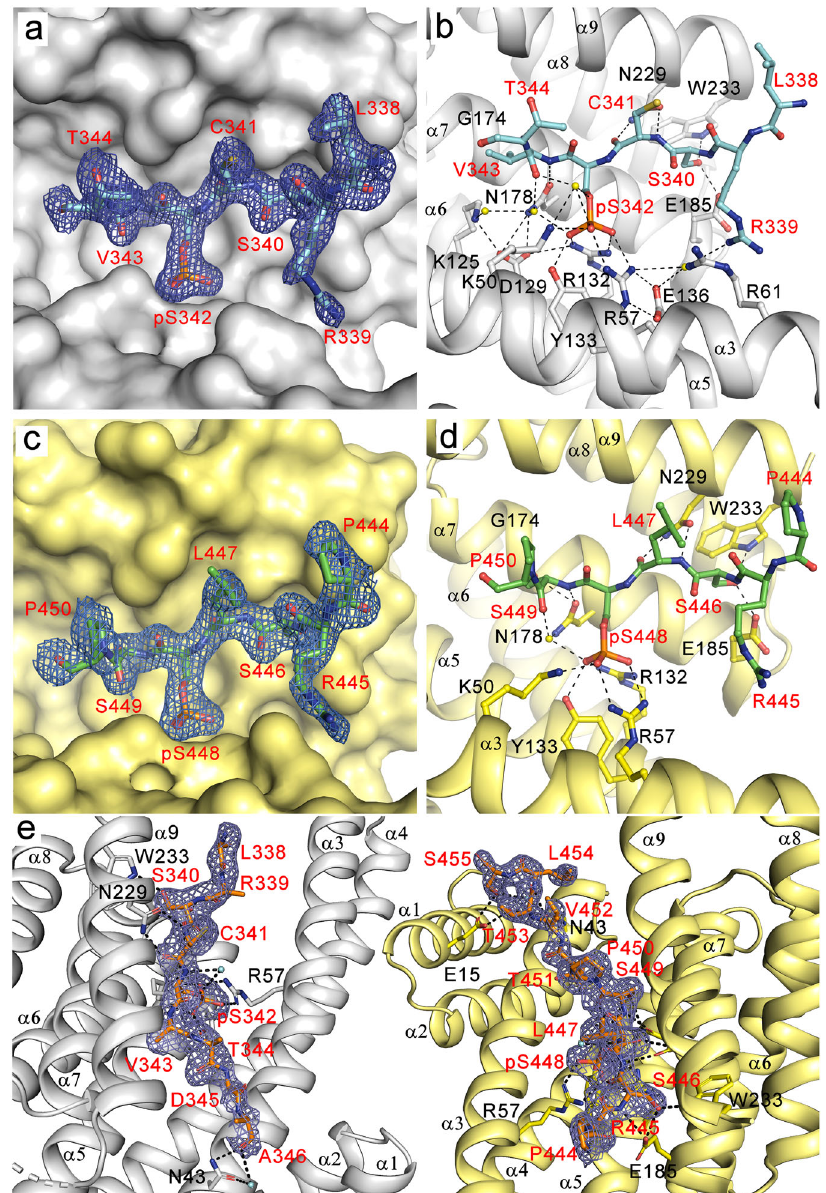
Fig. 5 Crystal structures of Nedd4-2 peptides containing the 14-3-3 binding motifs pSer342 and pSer448 bound to 14-3-3 γ and 14-3-3 η . a Detailed view of the crystal structure of the 14-3-3 γΔ C:pep-S342 complex. The 2F o -F c electron density map is contoured at 1 σ . b Polar contacts (black lines) between the residues of 14-3-3 γ (black) and the pSer 342 binding site of Nedd4-2 (red). Water molecules are shown as yellow spheres. c Detailed view of the crystal structure of the 14-3-3 γΔ C:pep-S448 complex. The 2F o -F c electron density map is contoured at 1 σ . d Polar contacts (black lines) between the residues of 14-3-3 γ (black) and the pSer 448 binding site of Nedd4-2 (red). Water molecules are shown as yellow spheres. e Crystal structure of Nedd4- 2 335 – 455 containing two phosphorylation sites (pSer 342 and pSer 448 ) bound to the 14-3-3 ηΔ C dimer: Top view of the intervening linker sequence of the two 14-3-3-binding motifs of Nedd4-2 and of the polar contacts (black dashed lines). The fi nal 2 F o – F c electron density map is contoured at 0.8 σ (blue mesh). Nedd4-2 residues are labeled in red, and 14-3-3 residues are labeled in black. Water molecules are shown as cyan spheres. Structure fi gures were generated using terminus of the HECT domain (#3 in Supplementary Table S3, Fig. 6b) primarily formed in the presence of 14-3-3 η . Table S3, Fig. 6a, b – in green). Upon complex formation, only the abundances of crosslinks #1 and #3 signi fi cantly changed, indicating that Nedd4-2 residues Lys 531 from the WW3 domain and Lys 607 from the HECT domain (#1 in Supplementary Table S3, Fig. 6b) are crosslinked mainly in the absence of 14-3-3 η . Conversely, the crosslink between the Nedd4-2 residues His 186 , which precedes the WW1 domain, and Lys 639 from the N-